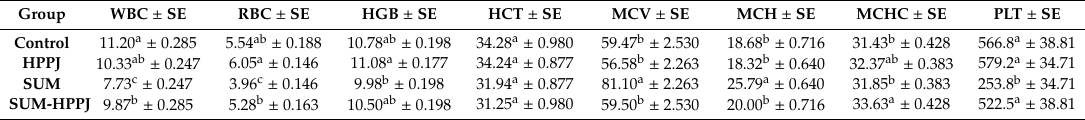
Means were statistically compared using the Tukey’s post-hoc multiple comparison methods at P ≤ 0.05. Means with the same superscript letter were not significantly di ff erent. Each treatment was replicated six times, and each replicate was measured three